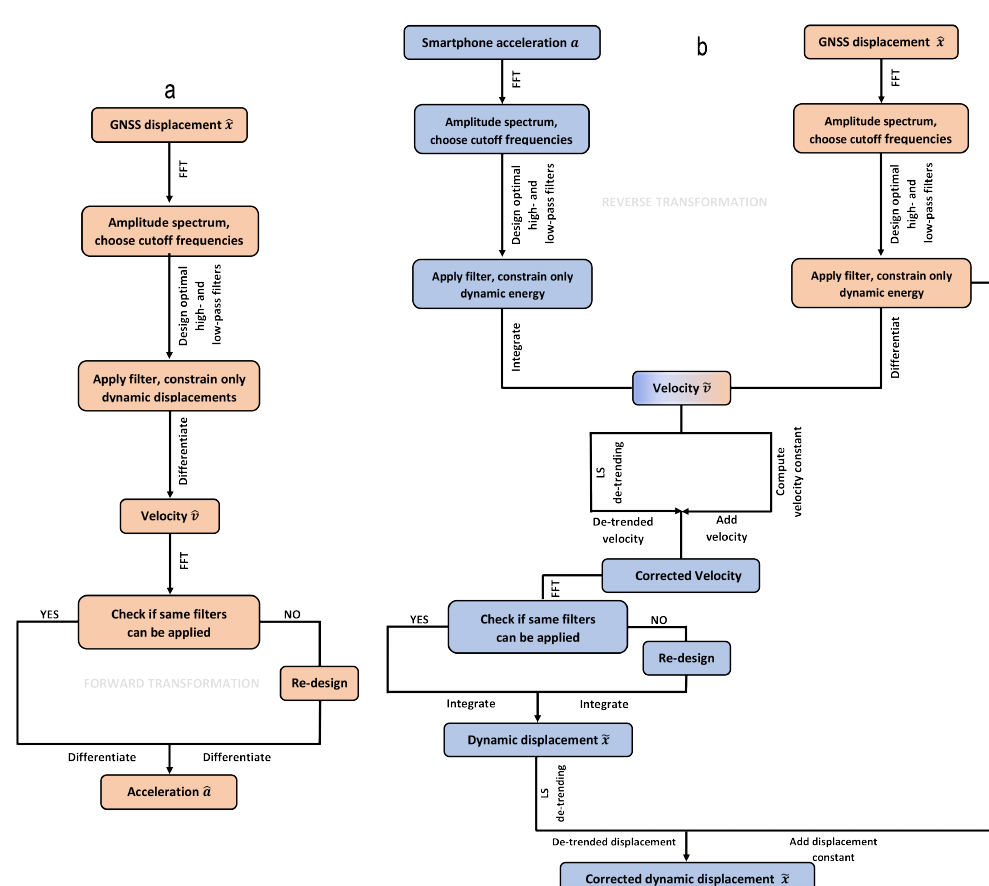
Figure A6. Schematics of validation methods: ( a ) Forward transformation for deriving acceleration information from GNSS-based displacements. ( b ) Reverse transformation for deriving displacement information from smartphone based accelerations. For more details please refer to [8,26].